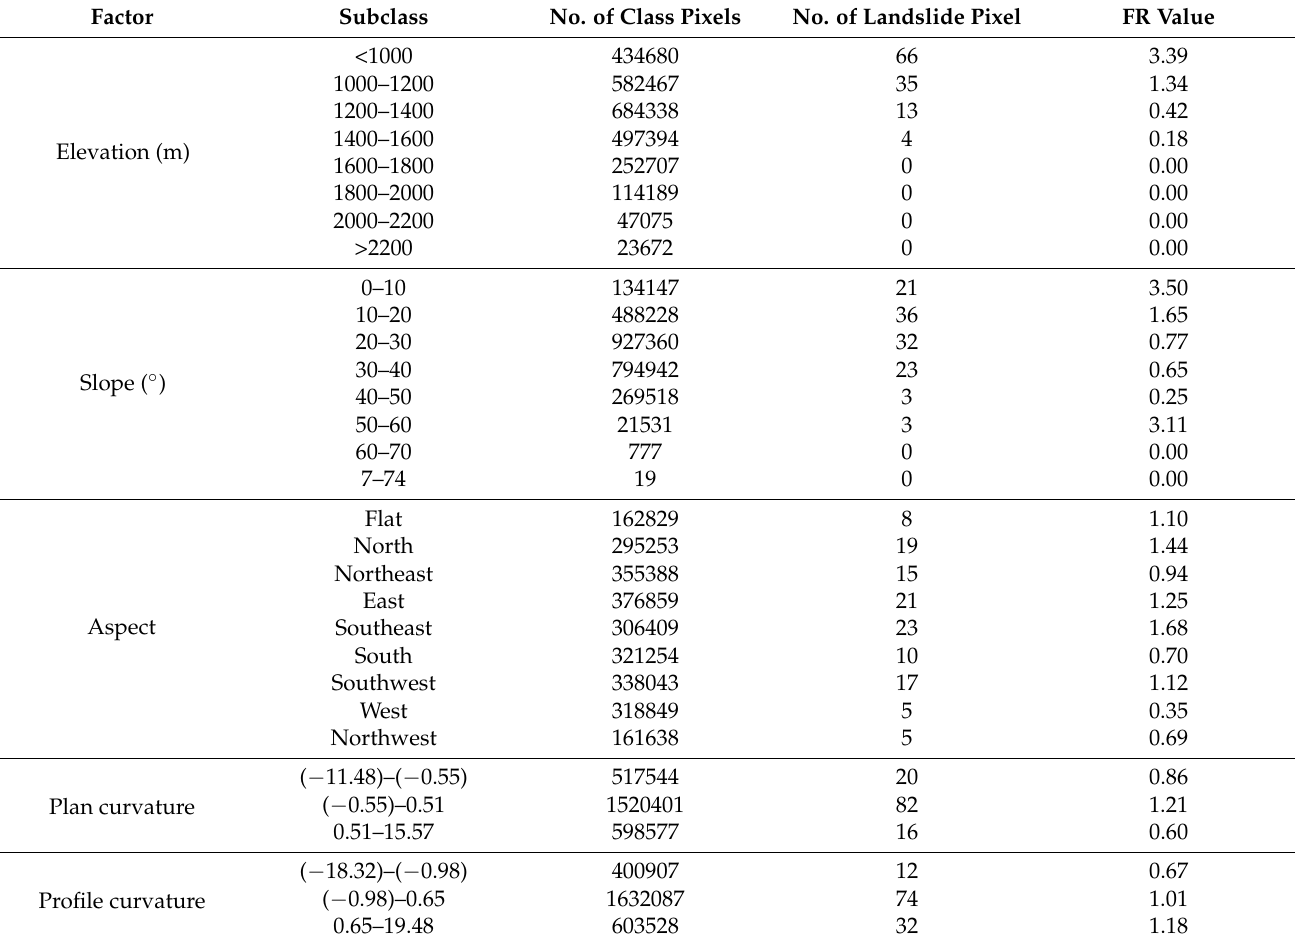
Table 3. Spatial relationship between conditioning factors and historical landslides using FR